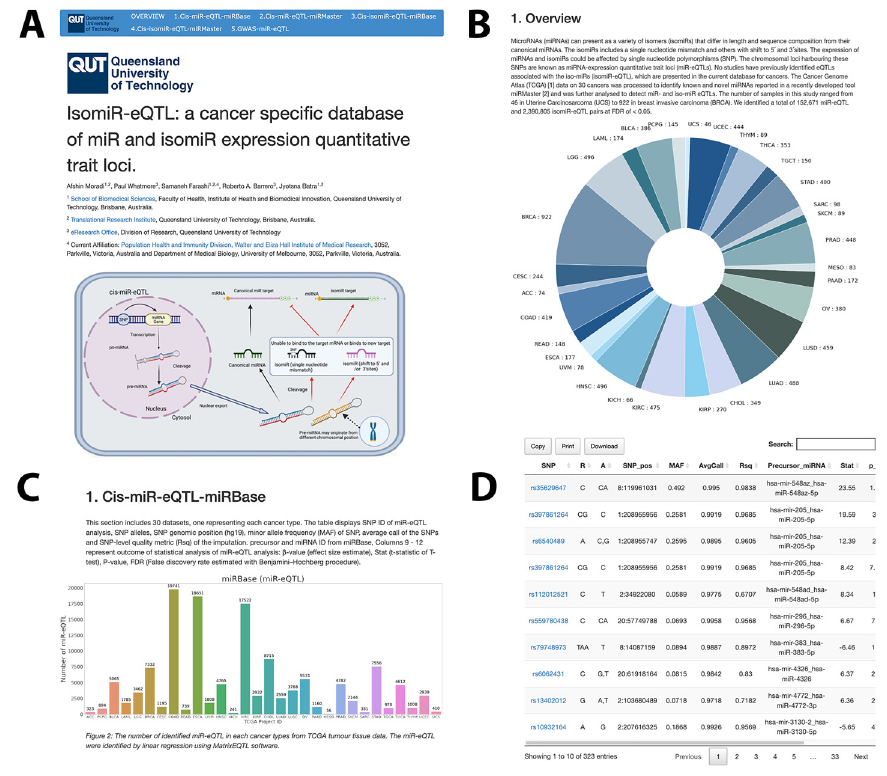
Figure 4. Web interface of the isomiR-eQTL database. ( A ) Home page. ( B ) Pie chart distribution of samples utilised for miR-eQTL analysis. ( C ) Each part includes an overview page that shows the number of identified miR-eQTL in each cancer type from TCGA tumour tissue data. ( D ) miR-eQTL tables include SNPs, alleles, SNP position, miRNA and statistical